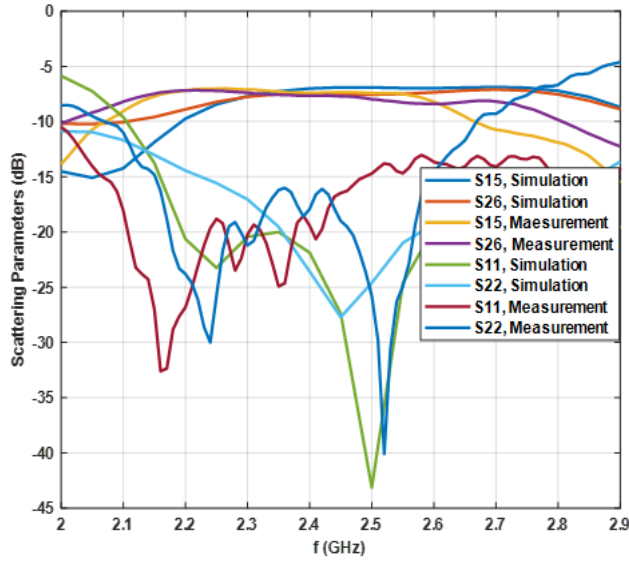
Figure 24. Scattering parameters for the proposed Butler matrix.